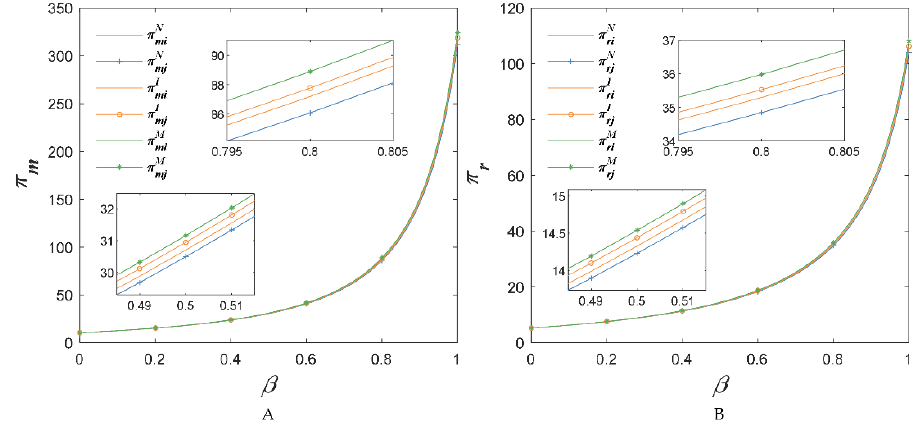
Figure 9. The price sensitivity coefficient of competitive agricultural products’ impact on income of suppliers ( A ) and retailers ( B ), when